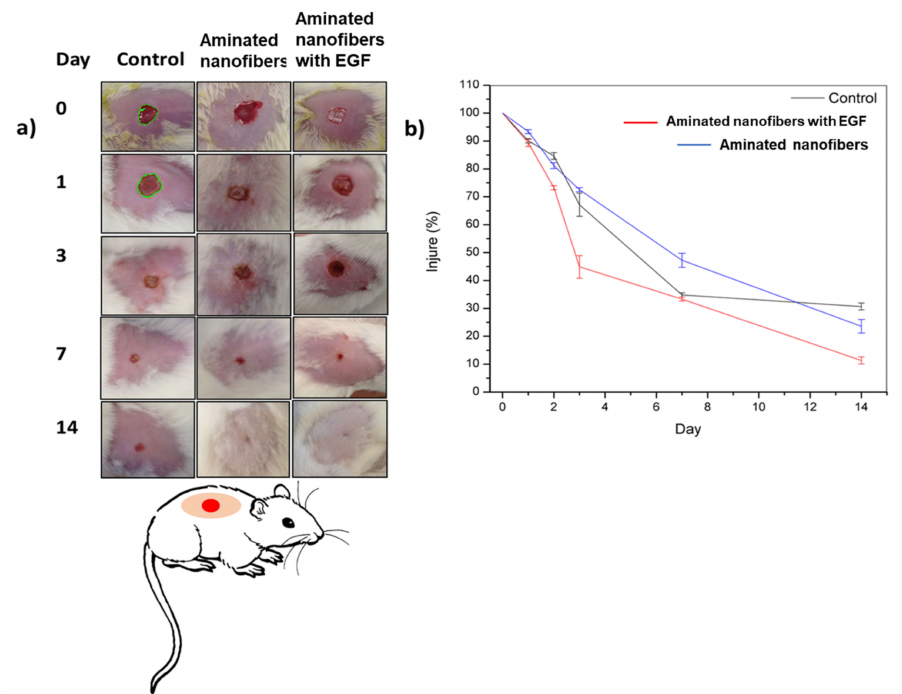
Figure 9. In vivo assay of tissue wound healing in rat model ( a ) wounds healing evolution; ( b ) graph wound healing percentage in the time (control: wounds without